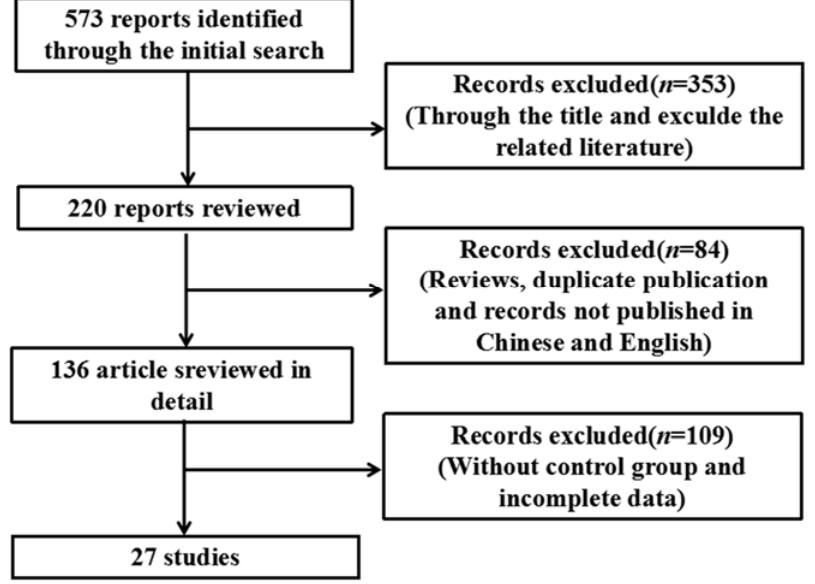
Figure 1. Flowchart detailing the publication search strategy.